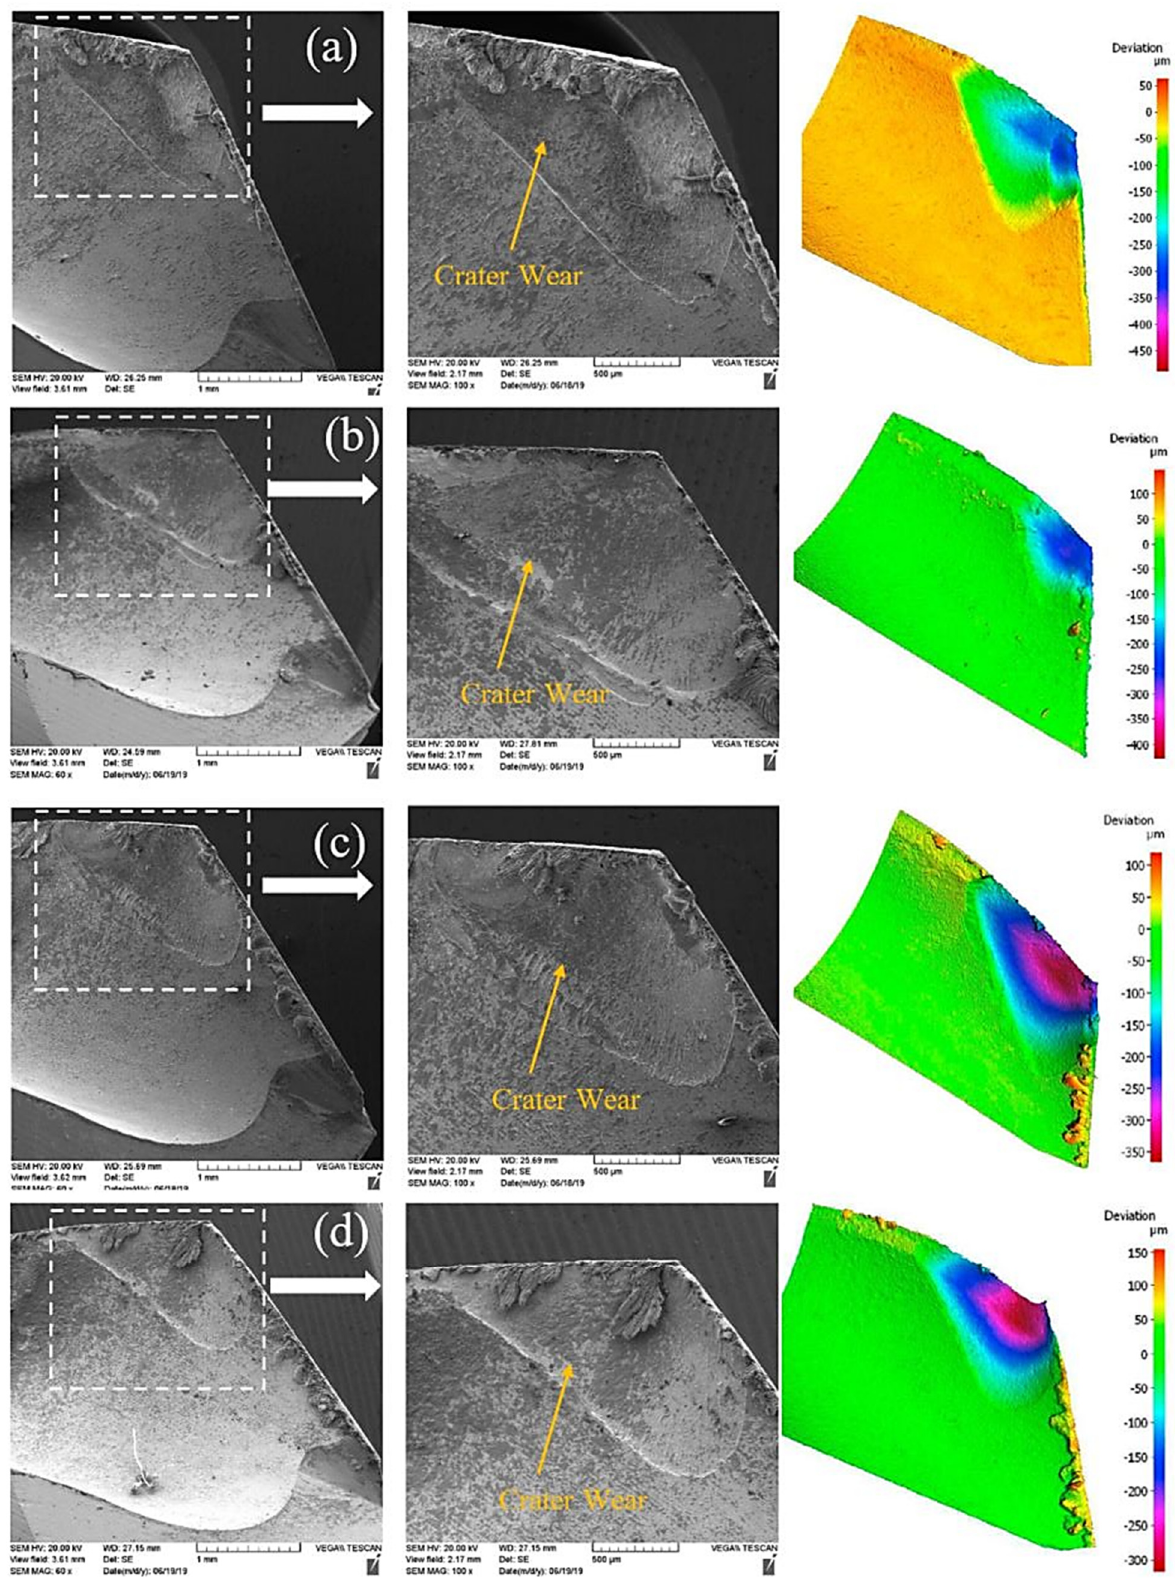
Figure 12. The SEM examination and surface topography analysis of the tool rake face at N = 3000 rpm for different vibration amplitude ( a ) conventional, ( b ) A m = 0.1 mm, ( c ) A m = 0.16 mm, and ( d ) A m = 0.25 mm.